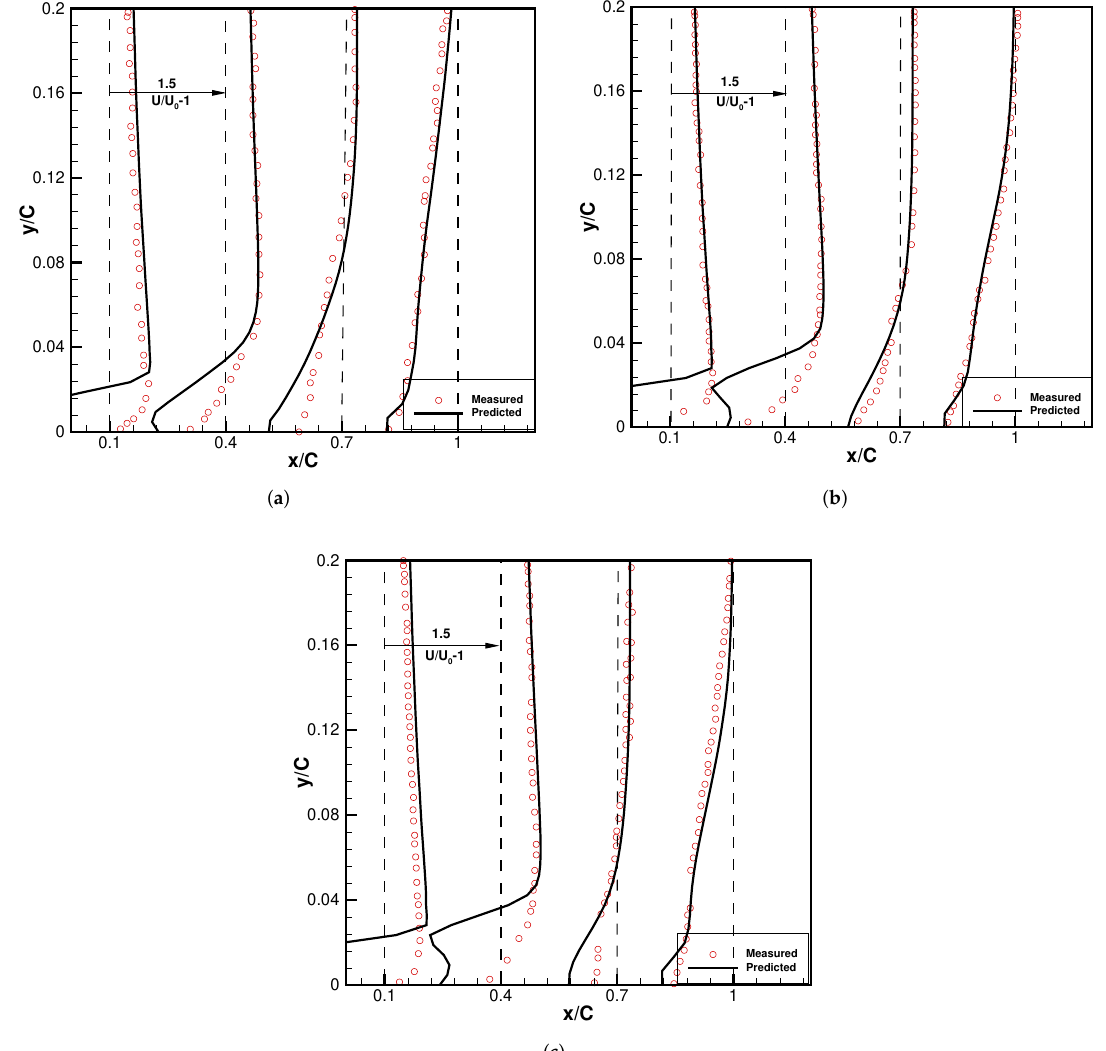
Figure 7. Validation against the experimental data of [4] for angle of attack 9 ( a ) with no injection (case AOA9b), ( b ) for mild injection (case AOA9c) and ( c ) for highest injection rate (case AOA9d)